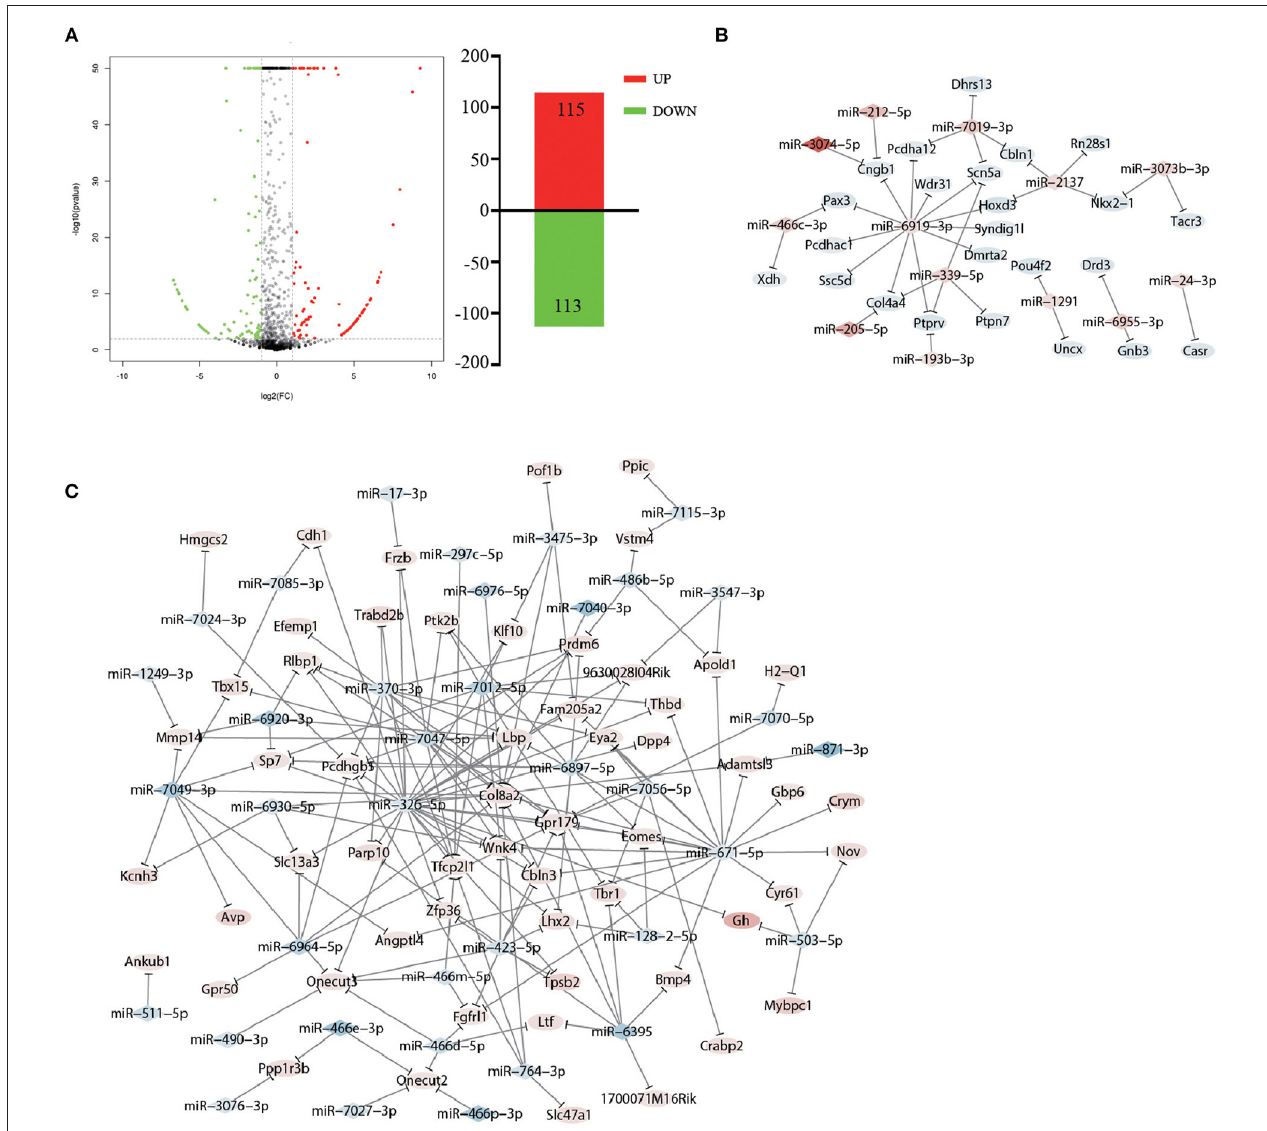
FIGURE 6 | miRNA expression in resilience mice was altered after accompanying with companion. (A) The MA plot displays the differently expression miRNAs distribution between CUMS-resilience mice and Companion-resilience mice, the column chart on the right is the number of statistical differently expression miRNAs. (B,C) miRNA-mRNA network in CUMS-resilience mice vs. Companion-resilience mice. The regulatory relationship was established between 50 miRNAs in miRNA profile and 82 DEGs in mRNA profile by the prediction from RNAhybrid, Targetscan, and miRanda databases. Diamonds symbols indicate miRNAs, ovals indicate mRNAs. The shades of red present the strength of the up-regulation of miRNA and mRNA. The shades of blue present the strength of the down-regulation of miRNA and